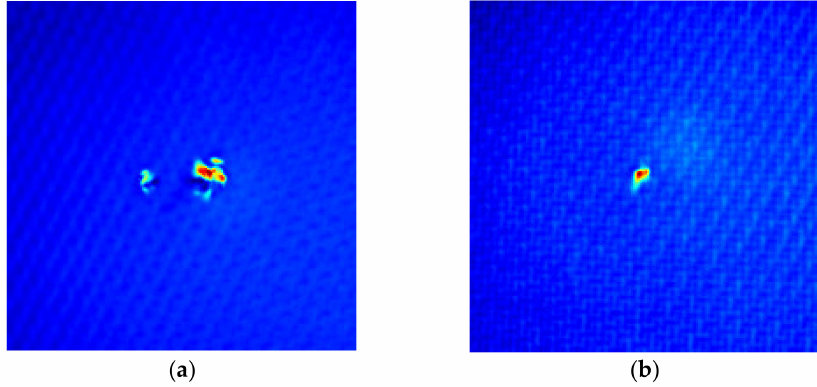
Figure 11. Thermographic images of the ( a ) front face and ( b ) back face of panel 11.